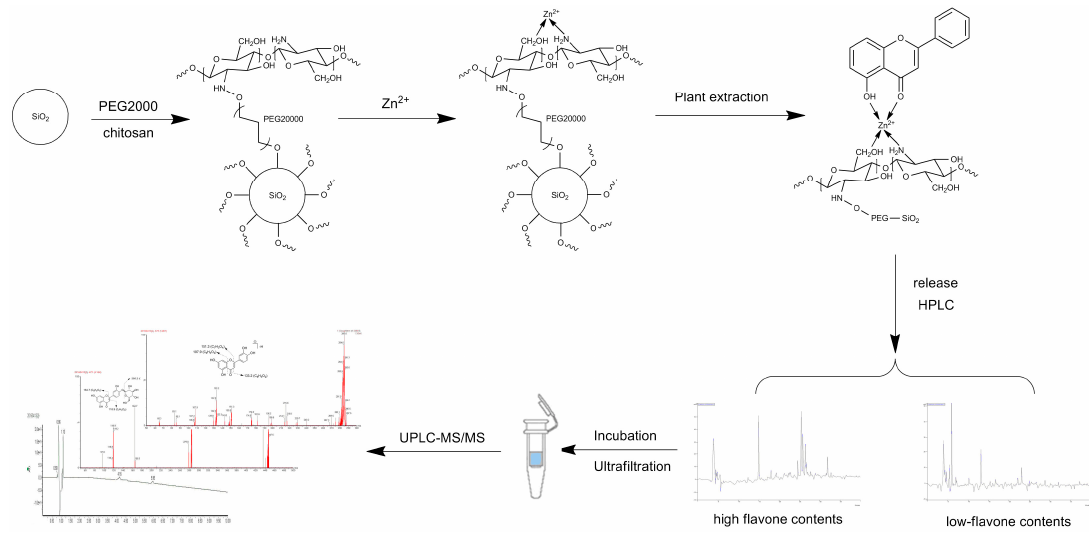
Figure 4. Schematic diagram of the IMAC-UF-UPLC-MS method.